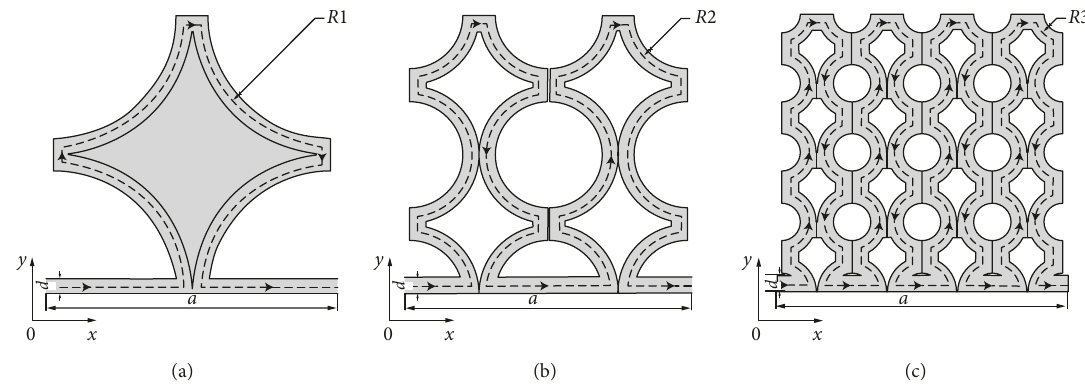
Figure 1: (a–c) Unit cells of the first-order to third-order fractal acoustic